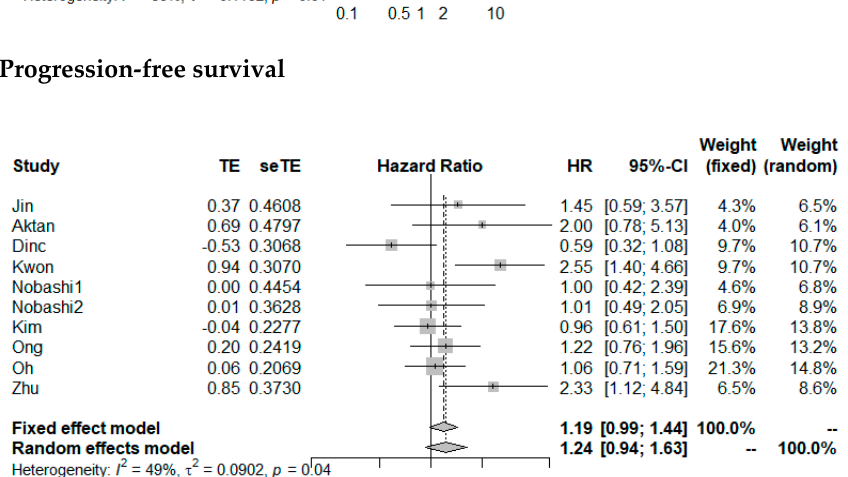
Figure 4. Forest plots of HRs of SUV max for overall survival and progression-free survival. Nobashi1 refers to the results of the central type of SCLC. Nobashi2 refers to the results of the peripheral type of SCLC. ChoiLD refers to the result of LD-SCLC. ChoiED refers to the results of SCLC-ED.